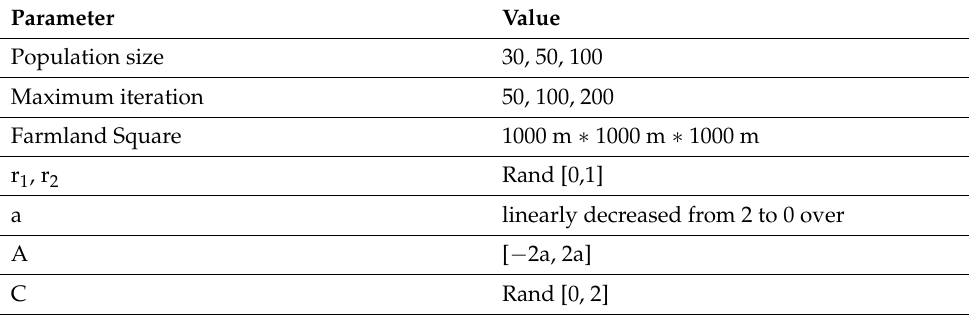
Table 1. The simulation